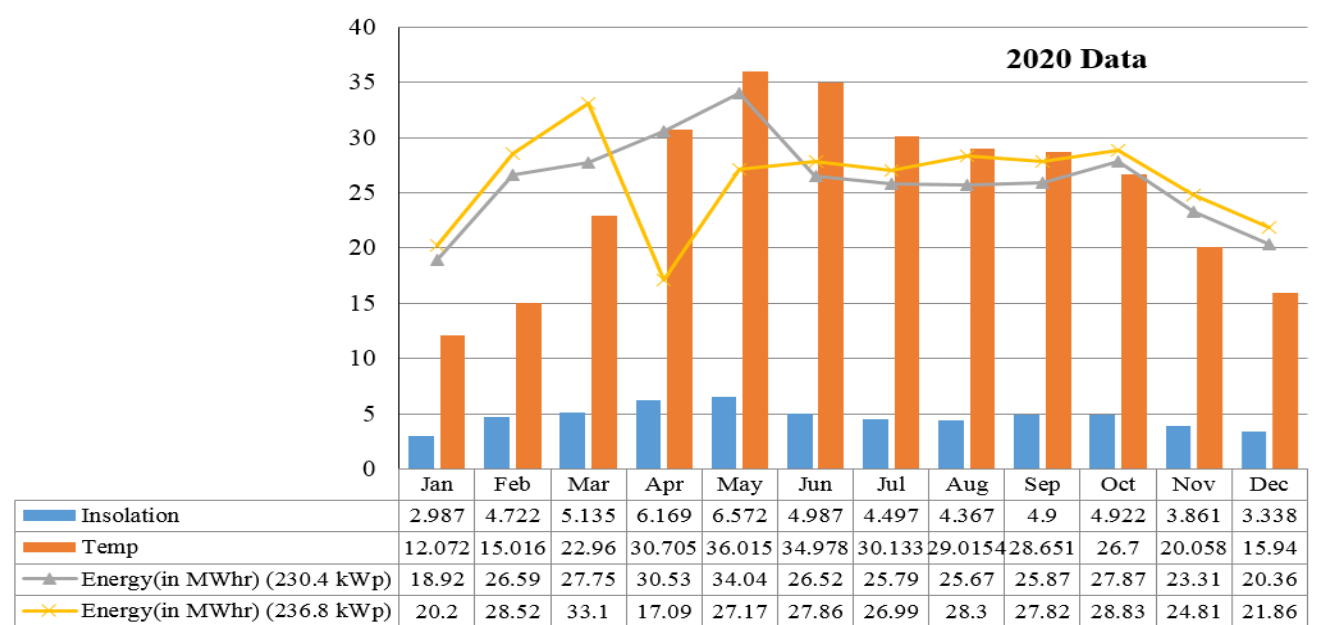
Figure 7. Comparison of Generated Energy in 2019 (P 1 vs. P 2 + P 3 ) .